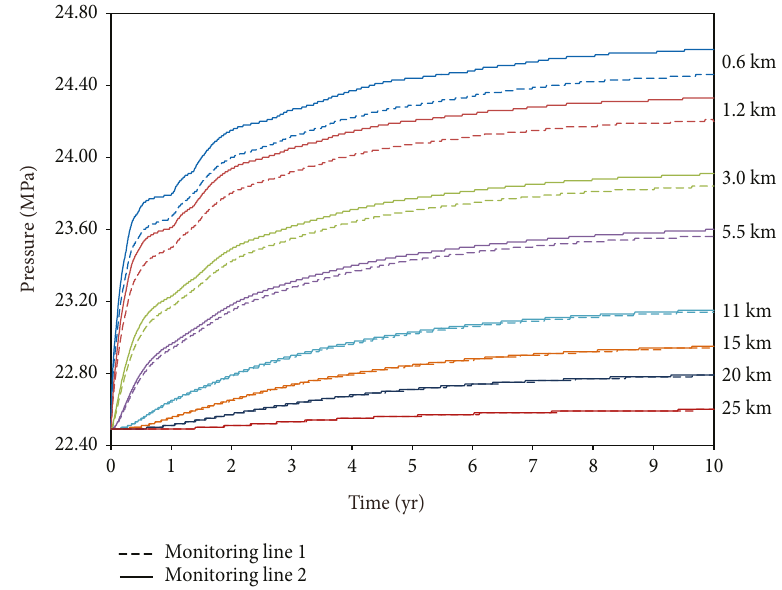
Figure 26: Pressure changes at the pressure monitoring points during injection in the 3-well